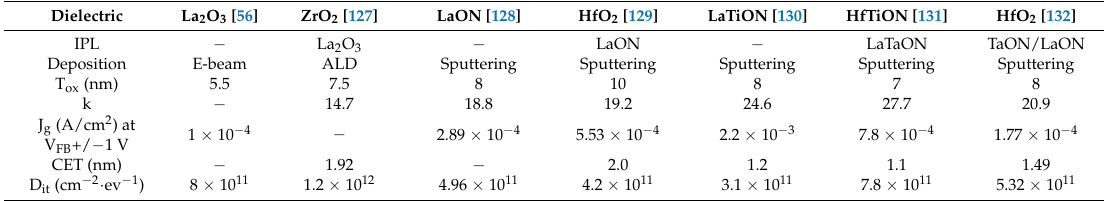
Table 5. Characteristics of Ge MOS devices with La-based high-k oxides as IPL or gate